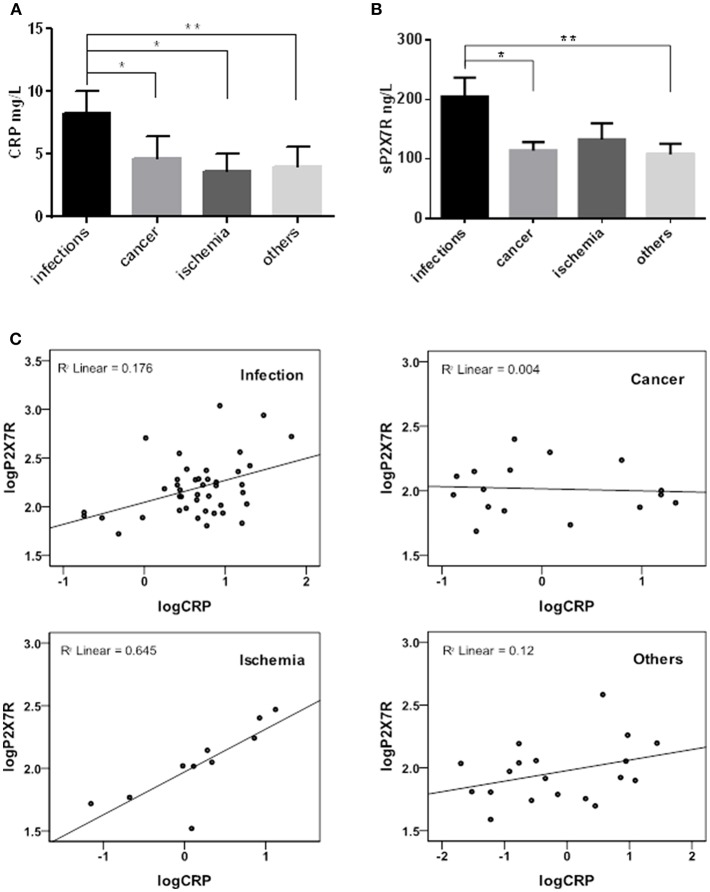
sP2X7R was differentially concentrated in different diagnosis sub-groups. CRP and sP2X7R were measured in serum samples stratified into four sub-groups according to diagnosis at admission to the hospital: infectious diseases (n = 42), cancer (n = 16), ischemia (n = 10) and others (trauma, autoimmune diseases) (n = 19). Data are means ± SE. Only significant differences are shown in the graphs. (A) Kruskal-Wallis test p = 0.0057; Mann Whitney test between groups: *p < 0.05; **p < 0.01. (B) Kruskal-Wallis test p = 0.0205; Mann Whitney test between groups: *p < 0.05; **p < 0.01. (C) Linear regression analysis between log-transformed CRP and sP2X7R in the different diagnosis sub-groups: ischemia, R2 linear = 0.645; infectious diseases, R2 linear = 0.176; cancer, R2 linear = 0.004; others, R2 linear = 0.12.